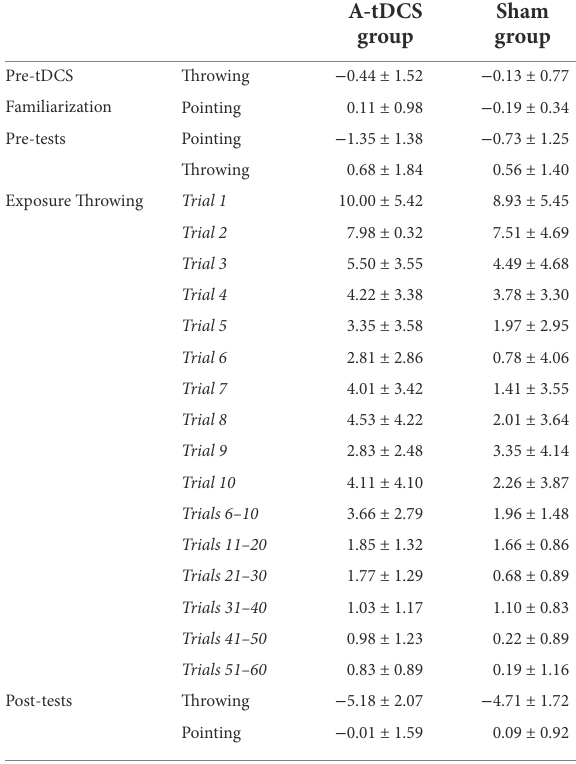
TABLE 1 Mean group terminal errors during the task